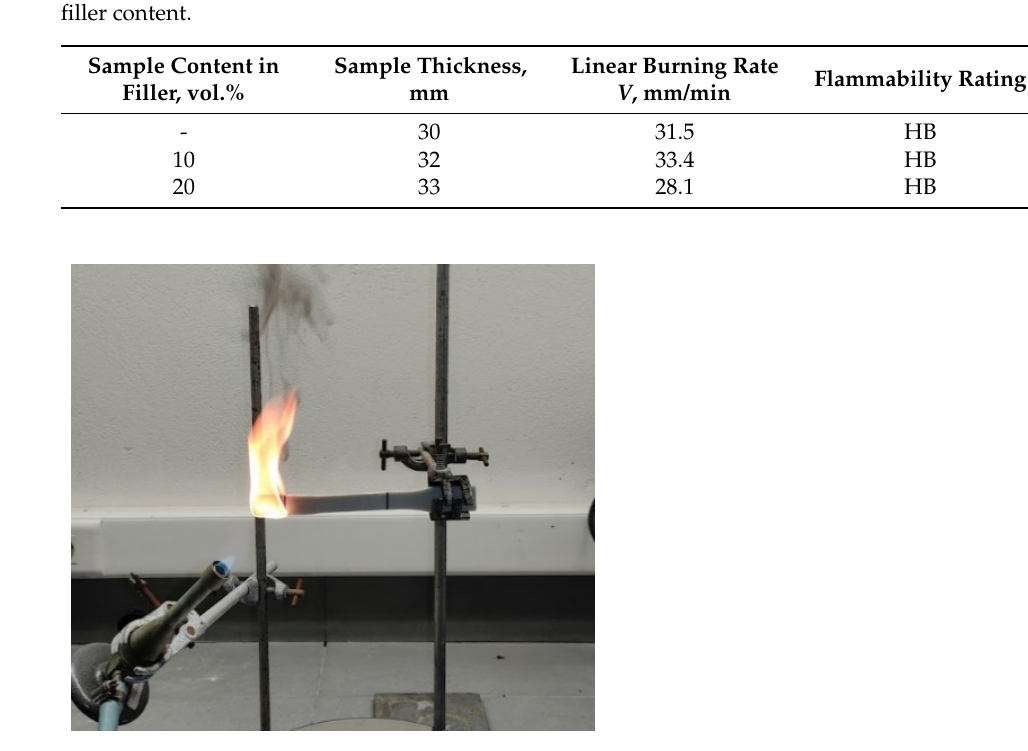
Figure 13. Snapshot of flammability testing of the sample with infill ratio of 10 vol.%. Table 3. Flammability of neat ABS sample and samples prepared with composite filaments of dif- ferent filler content.